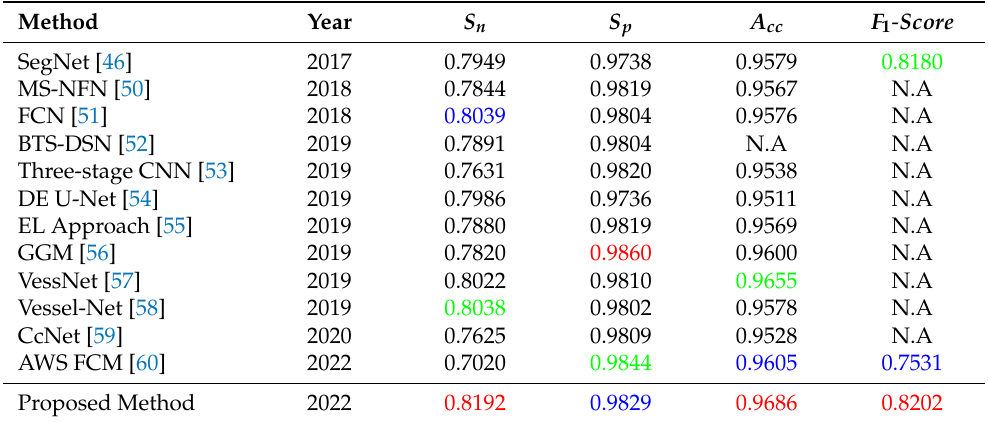
Table 2. Comparison results on DRIVE dataset. Red is the best, green is the 2nd best, and blue is the 3rd best.